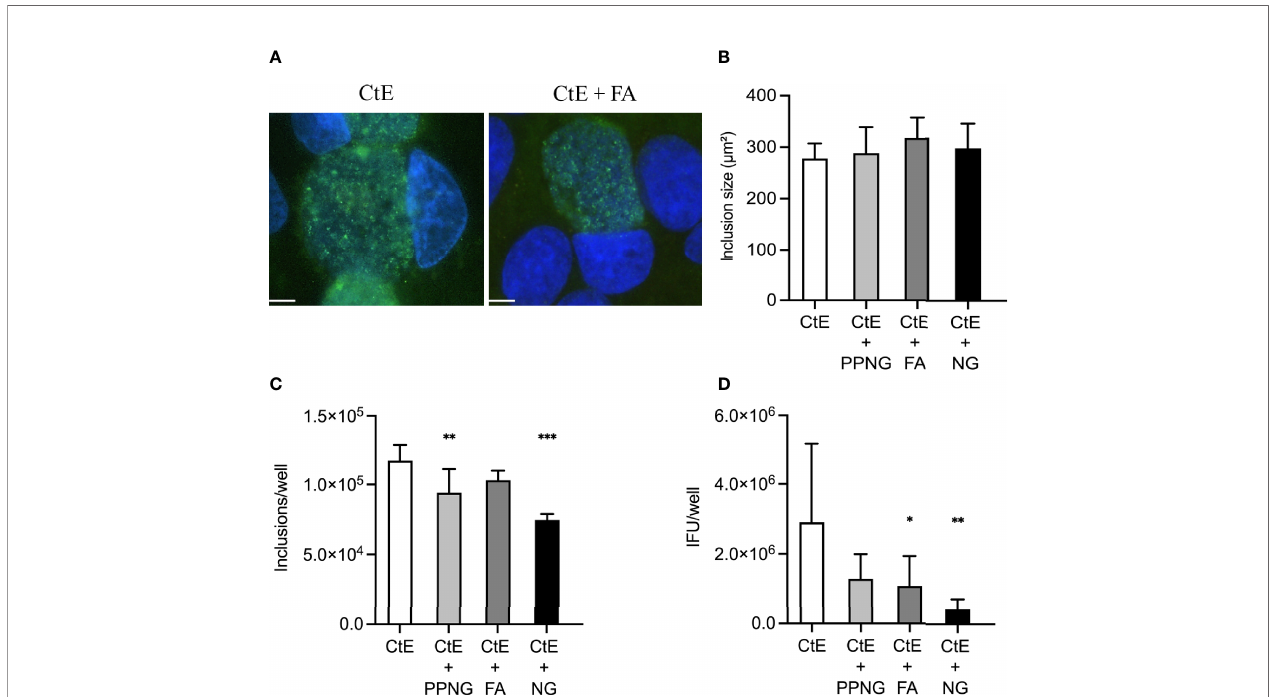
FIGURE 4 | Gentamycin exposure after pre-infection of host cells with Ng limits Ng-dependent anti-chlamydial effects on CtE inclusion development and infectivity. HeLa cells were infected with Ng (10 6 CFU/well) in cycloheximide-supplemented culture medium for 24 h prior to subsequent CtE infection. Immediately after CtE infection, inocula were replaced with fresh cycloheximide- and gentamycin-supplemented culture medium ( Figure 1A ). Cycloheximide- and gentamycin- supplemented culture medium was refreshed at 20 h post-CtE infection and samples were processed for IF analysis of inclusion formation/development or determination of infectivity (IFU/well) at 40 h post-CtE infection. Representative micrographs (A) of CtE (left) and CtE + FA (right) experimental groups, CtE inclusion size (B) (expressed as inclusion area, m m 2 ), CtE inclusions/well (C) , and CtE IFU/well (D) are shown. Scale bars = 5 µm; DAPI staining of DNA is indicated in blue and LPS immunolabeling of CtE is indicated in green. Signi fi cant differences from the control are indicated with asterisks: * p < 0.05, ** p < 0.01, *** p <